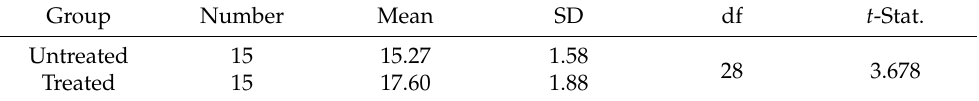
Table 2. The independent t -test for comparing the score between the untreated and treated groups. Group Number Mean t